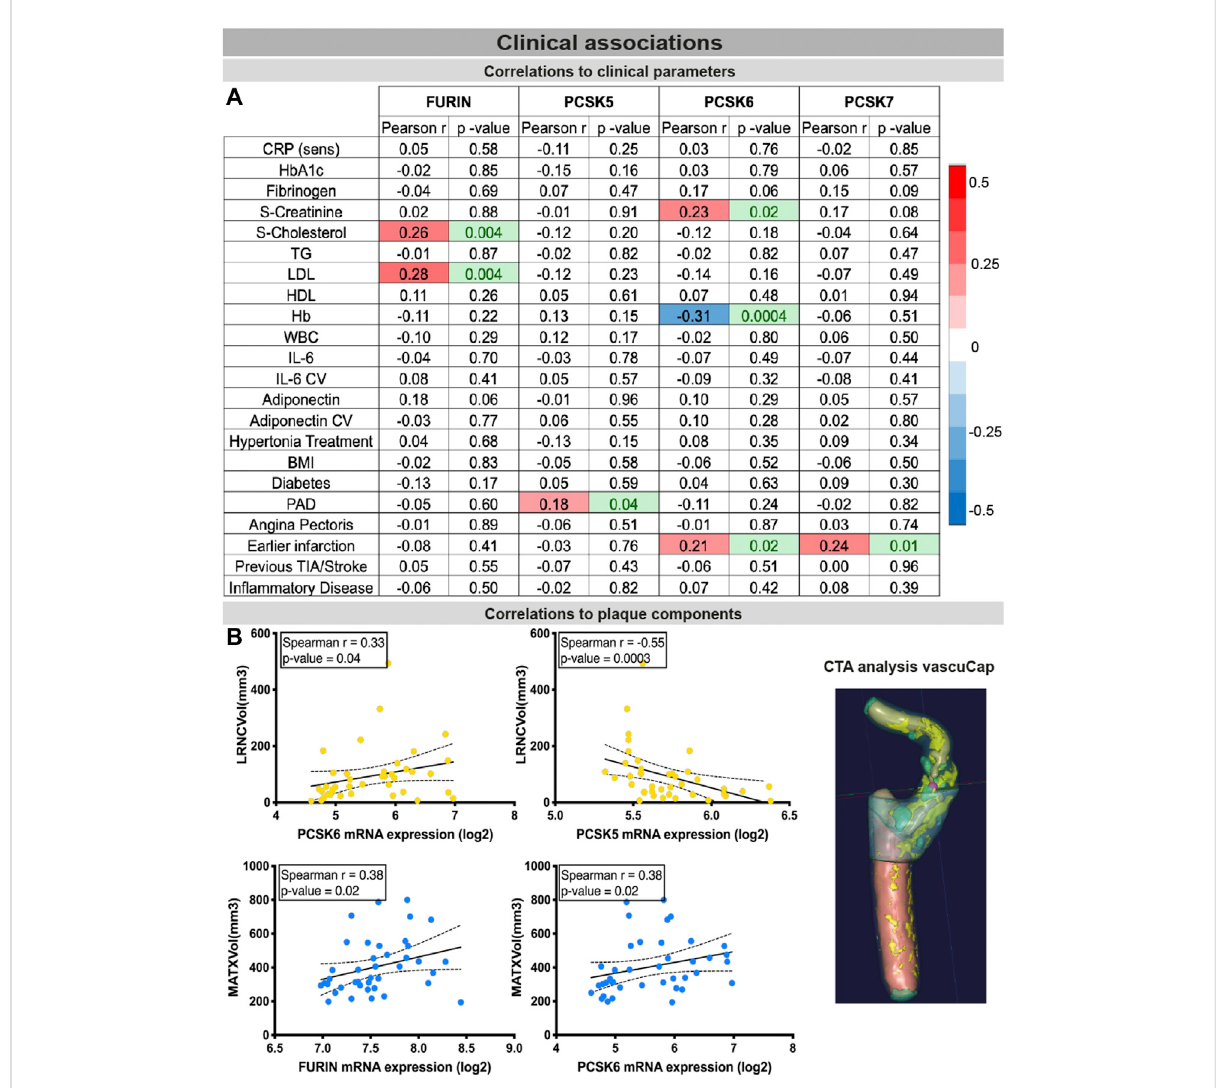
FIGURE 7 Associations of PCSKs expression in plaques with clinical data from matched patients. Pearson correlations of the FURIN and PCSKs5-7 mRNA expression in carotid plaques with biochemical blood parameters of patients undergoing carotid endarterectomy (A) . Expression of FURIN, PCSK5 and PCSK6 in plaque tissues correlated with different morphological plaque components, based on computed tomography image analysis with vascuCap software (B) . Peripheral arterial disease